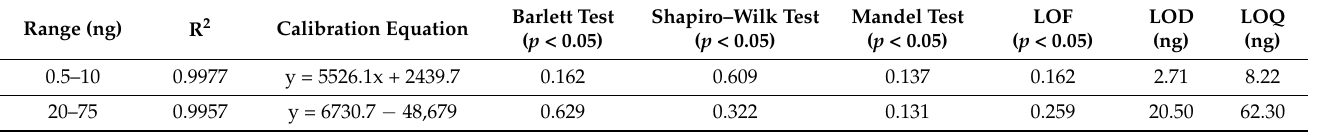
Table 8. Validation of the HPLC-DAD chromatographic method for the vit D3 recovery analysis. Range (ng) R 2 Calibration